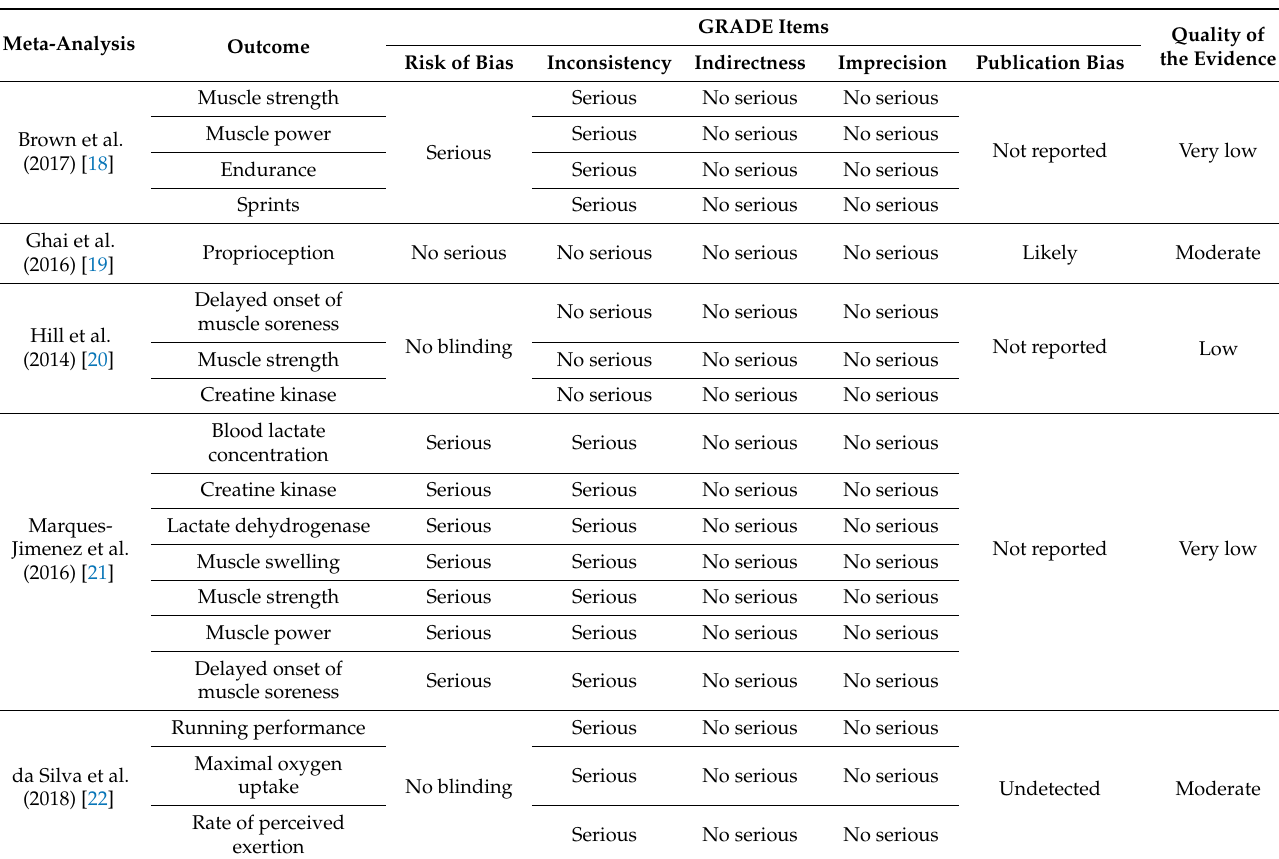
Table 3. Quality of evidence for each outcome of the included meta-analyses using Grading of Recommendations Assessment, Development and Evaluation